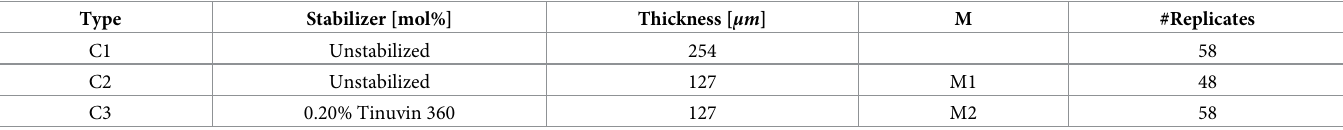
Table 1. Properties of clear grades of PET film. “Unstabilized” indicates that the samples are free of chemical stabilizers. “M” represents the material grade indicator vari- able encoding that will be used for modeling of clear films. “#Replicates” represents the number of individual replicates for each grade in the study.